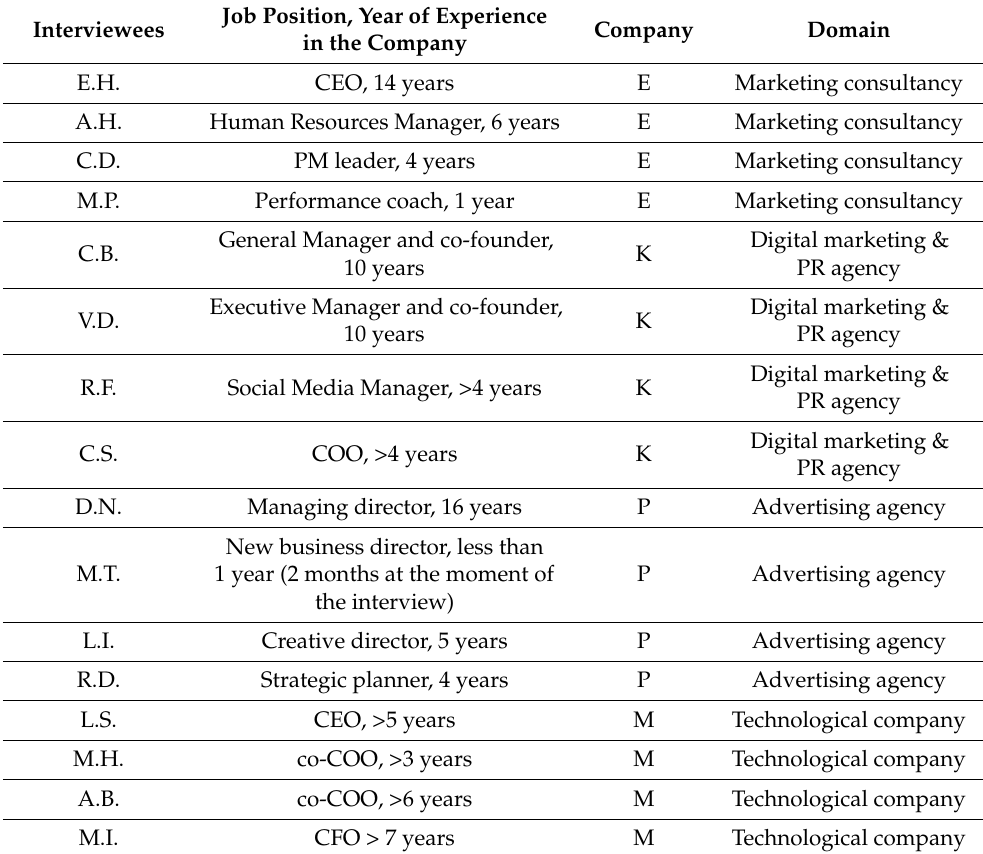
Table 1. Structure of the sample.